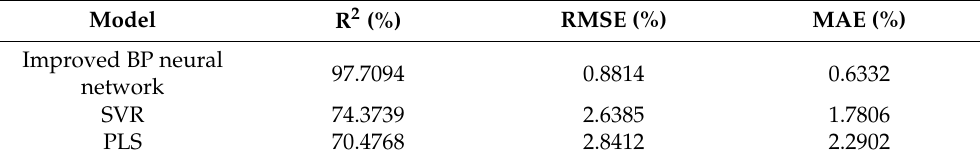
Table 6. Improvements to the prediction effect of the BP neural network model and the other models.